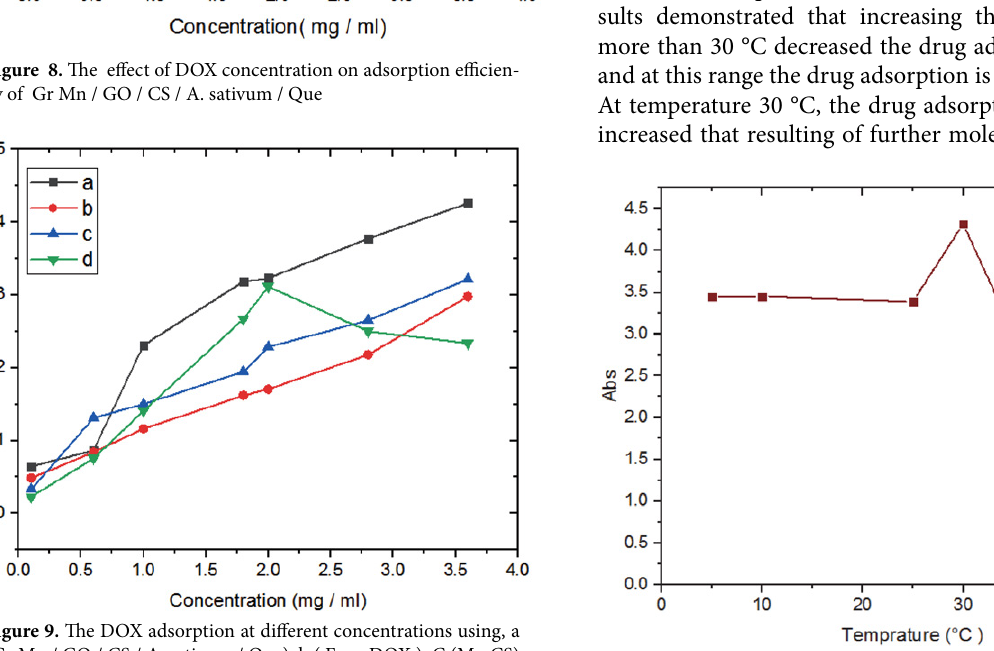
Figure 11. Effect of temperature on drug adsorption